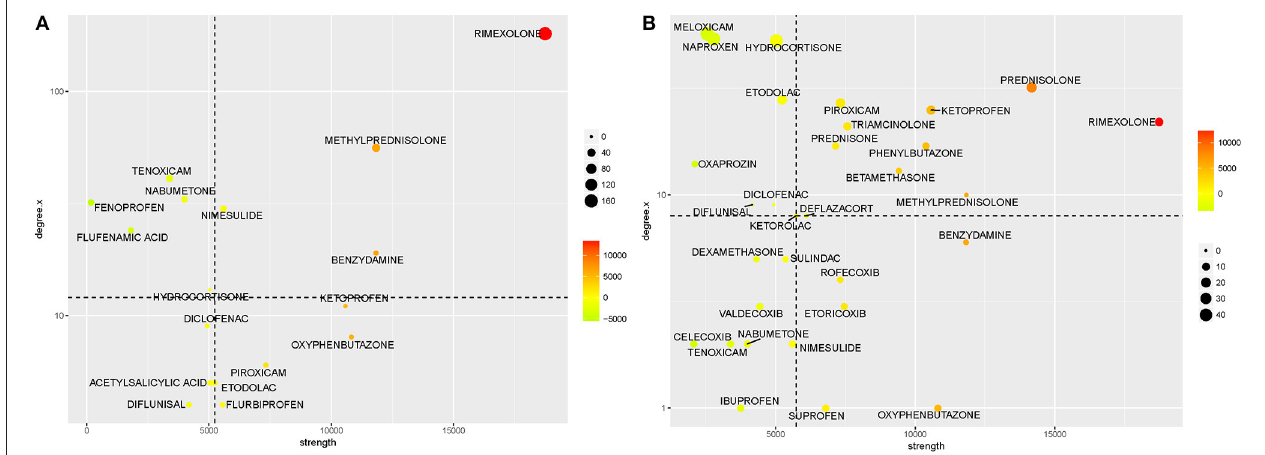
FIGURE 6 | Toxic and therapeutic potential of the anti-inflammatory drug space. In these figures, drugs are classified based on their risk of producing an adverse drug reaction (ADR, measured as the node strength from the drug-ADR network) and their potential alternative therapeutic uses [measured as the degree in a drug-pathway network, either derived from (A) the Connectivity Map (CMap) or (B) Library of Integrated Network-based Cellular Signatures (LINCS)]. Each axis is divided by its median value. Point color and size are proportional to position in the x and y axes. Following this classification, drugs in the upper, left quarter are the best repositioning candidates, as they have the most effects on alternative pathways and the least risk for